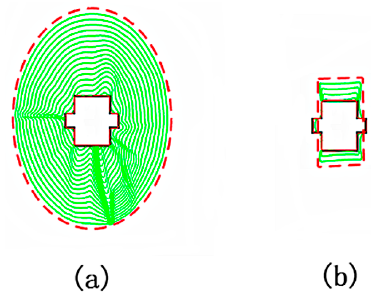
Figure 4. ( a ) Evolution of the contour when the initial contour is large; and ( b ) evolution of the contour when the initial contour is small.